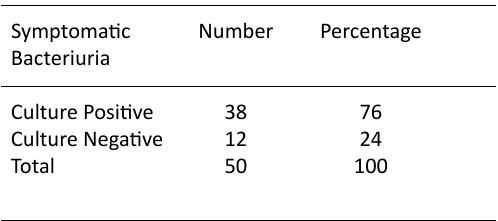
Table 5. Bacterial isolates in asymptomatic and symptomatic Bacteriuric cases.